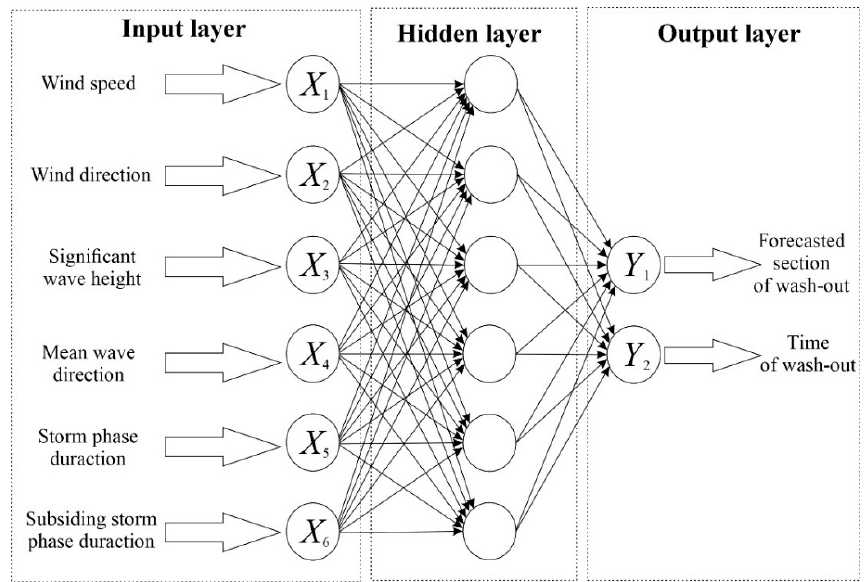
Figure 9. The ANN structure for analysis of natural conditions.